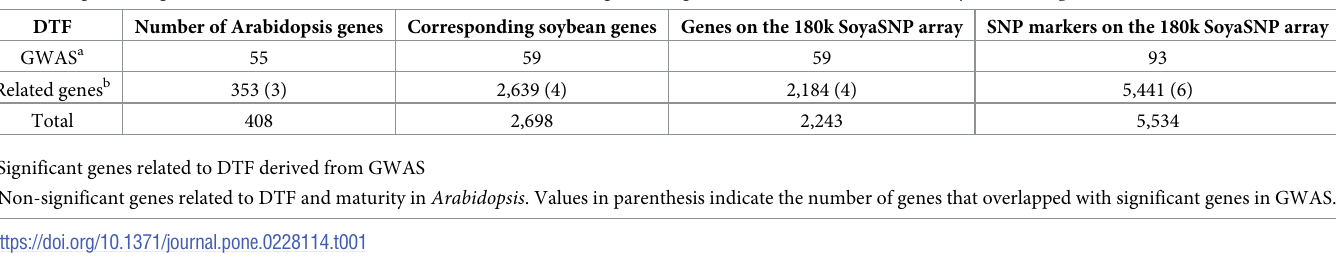
Table 1. Significant genes related to DTF derived from GWAS, and non-significant genes related to DTF and maturity in Arabidopsis . DTF